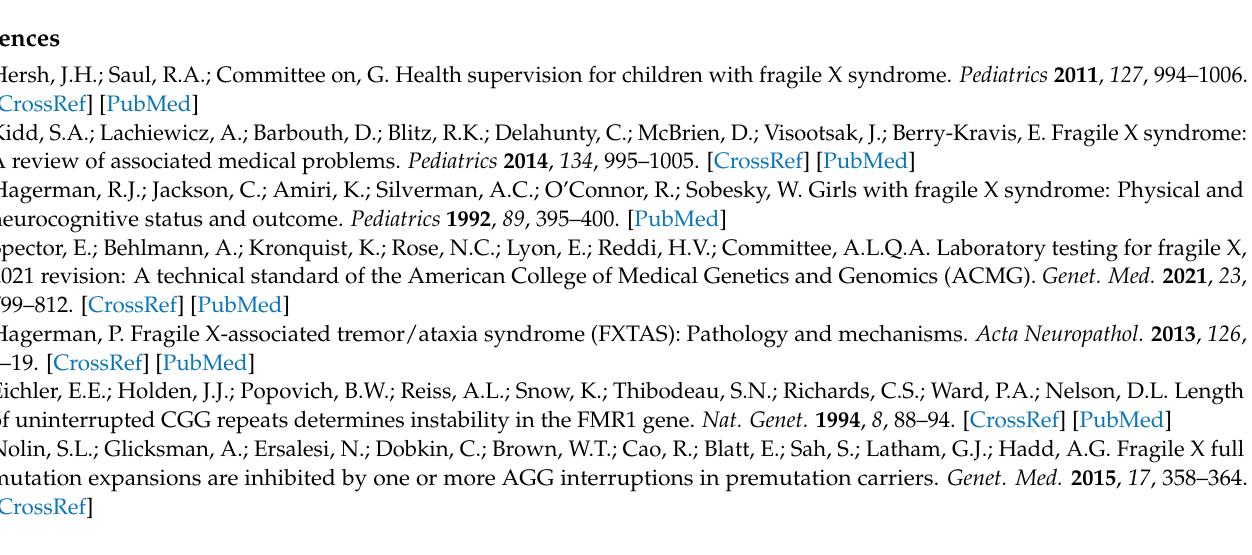
Table S2: Phenotypes of individuals reported with FMR1 CNVs; Table S3: All published coding region small variants; Table S4: Phenotypes of individuals reported with FMR1 coding variants; Table S5: All published noncoding small variants; Table S6: Phenotypes of individuals reported with FMR1 splice/noncoding